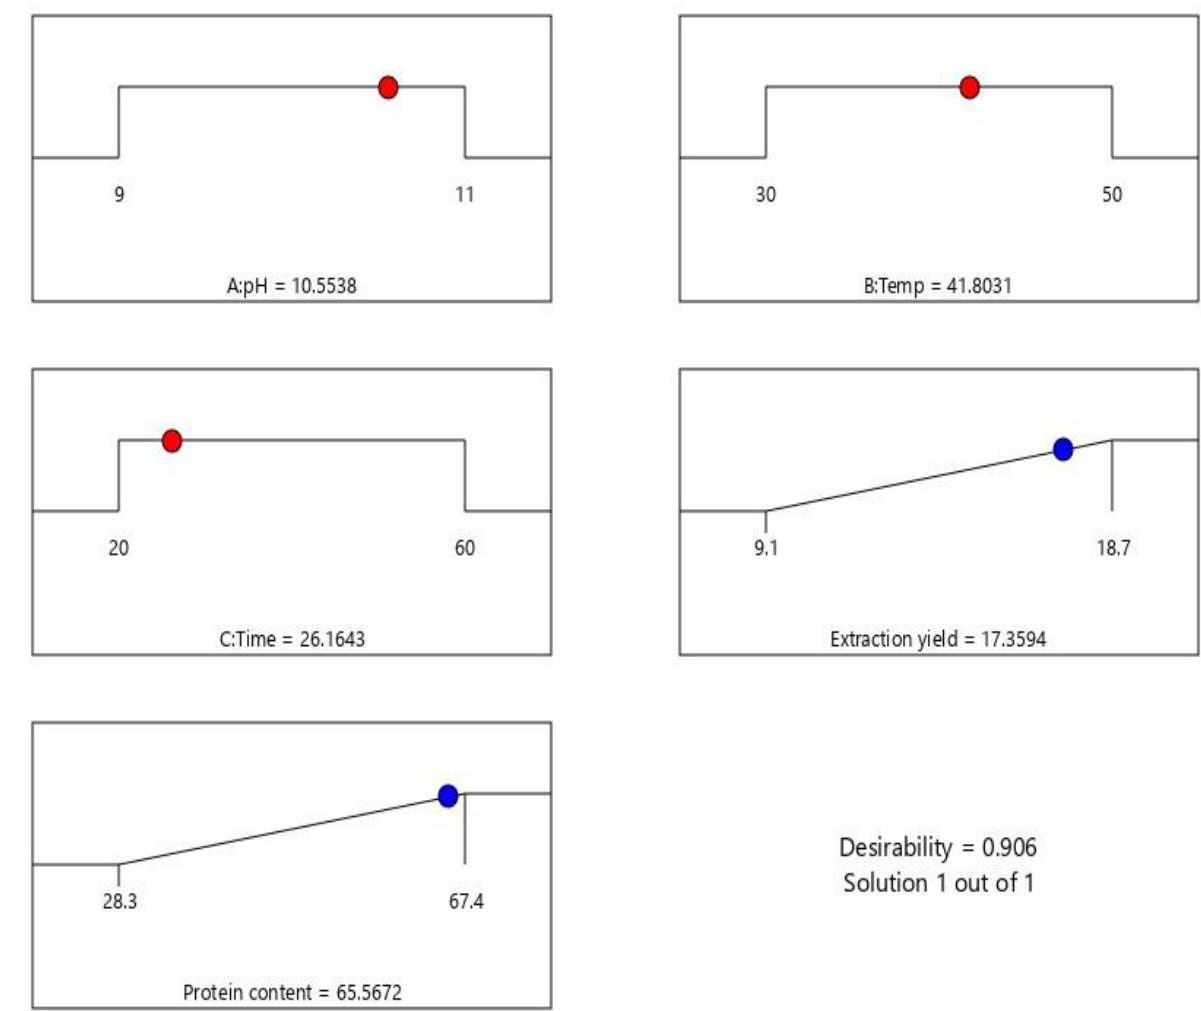
Figure 3. Optimized conditions of ultrasound-assisted alkaline extraction of protein from cherimoya seed.